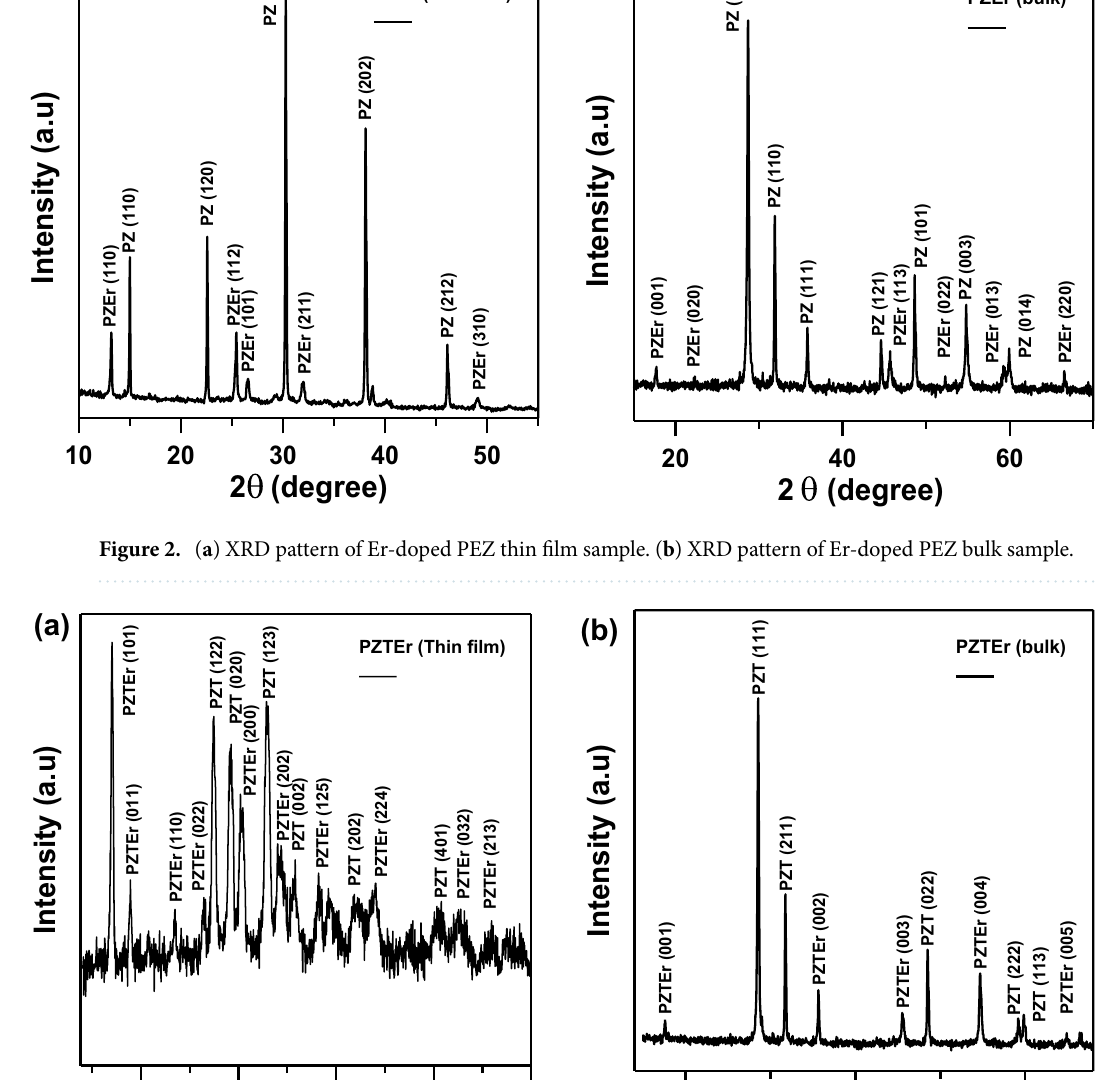
k (cid:31) β cos θ